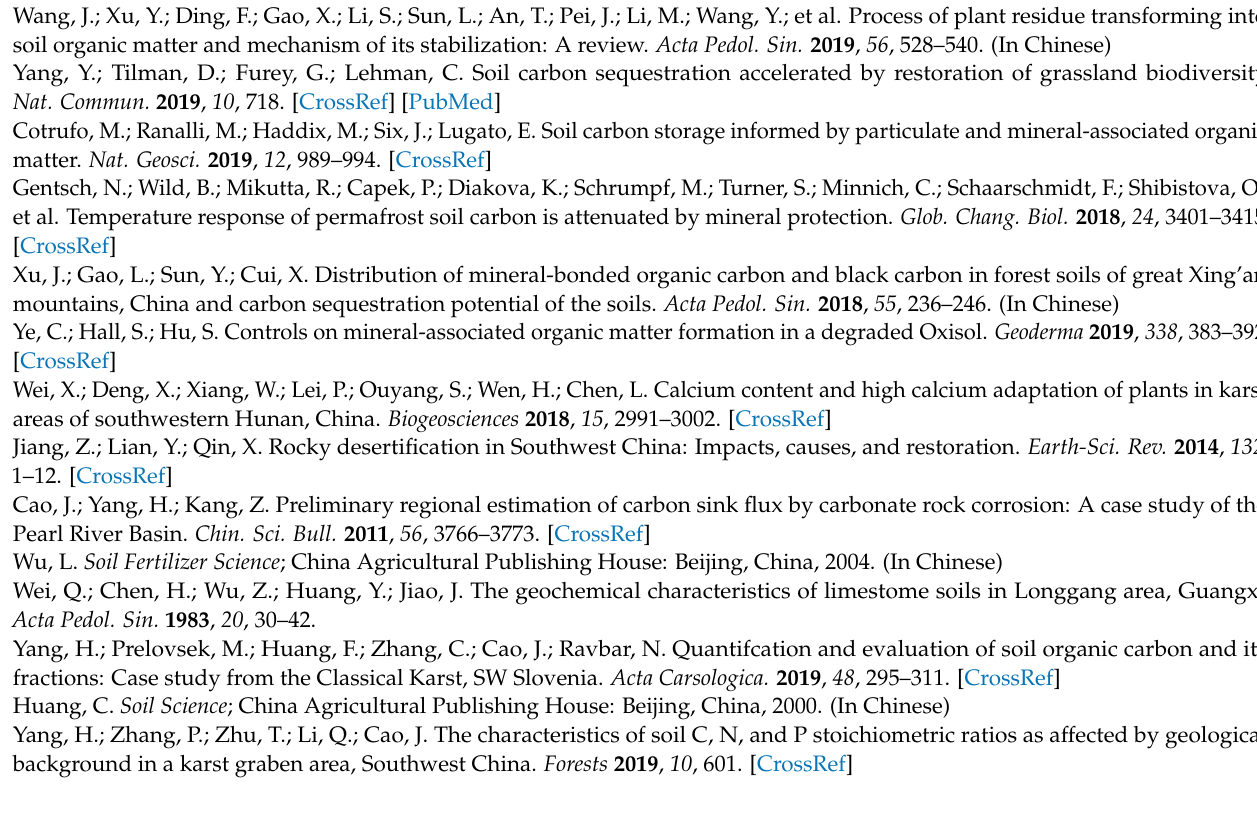
groups (indicated by PLFA) in the subtropical evergreen broadleaved forest of southwest of China. Figure S2: Principal component analysis (PCA) of microbial phospholipid fatty acids (PLFAs, vectors with different color lines). Figure S3: Principal component analysis (PCA) of extractable cations (vectors with different color lines). Figure S4: Correlation of microbial phospholipid fatty acids with water holding capacity in the subtropical karst area of southwest China. Figure S5: Correlation of SOC fractions with microbial phospholipid fatty acids in the subtropical karst area of southwest China. Table S1: Basic information of the study area and sampling sites. Table S2: The phospholipid fatty acids detected in this study (Chen et al., 2020). Table S3. Total organic C (OC), nitrogen (N), and C/N ratios of OM